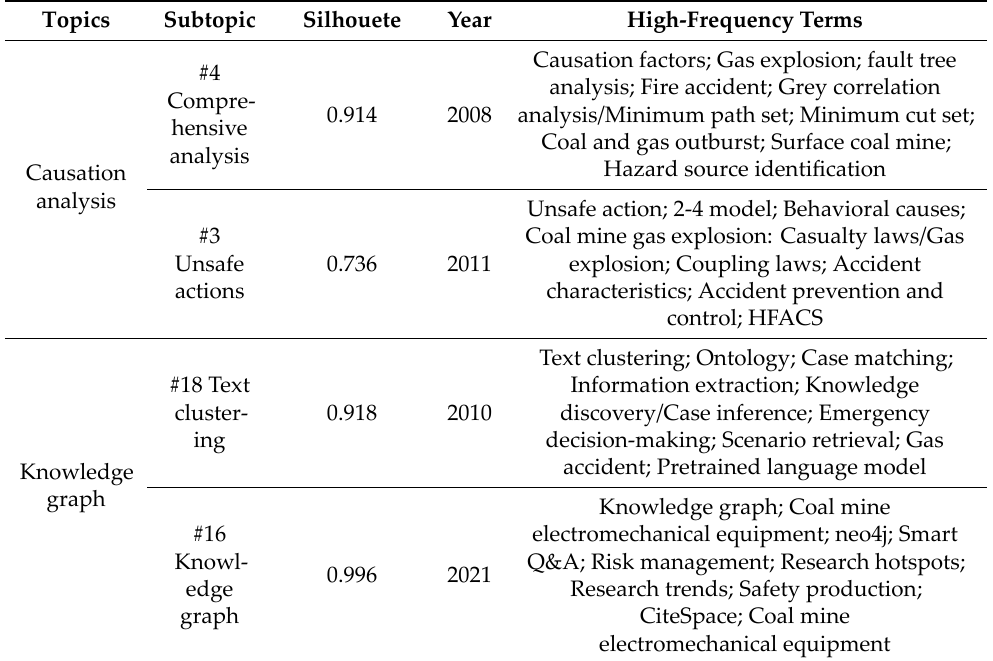
Table 2. Topic and top term of accident